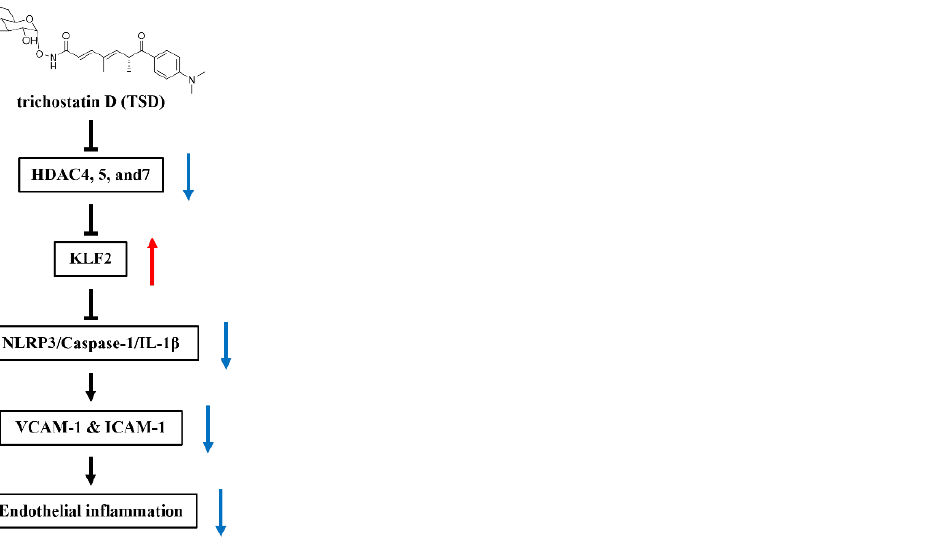
Figure 7. The main signal pathway by which TSD inhibits inflammation in HUVECs. The red arrow means up-regualtion, and the blue arrow means down-regulation.